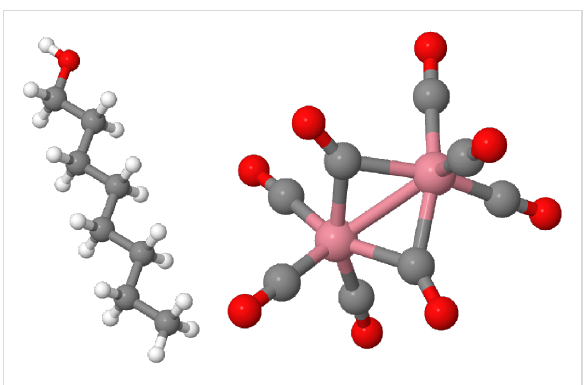
Figure 4: Simulation of concentration of different elements in FEBID structure under parallel use of Co 2 (CO) 8 and octanol as precursors. The dissociation product of Co 2 (CO) 8 is assumed to have the compo- sition Co 2 C 0.6 O 0.4 , whereas for the octanol the composition C 8.5 O 1 is assumed. Inset: Dissociation yield ratio for Co 2 (CO) 8 and octanol from solving Equation 14 and using Equation 17 (abscissa units as in main graph). See text for